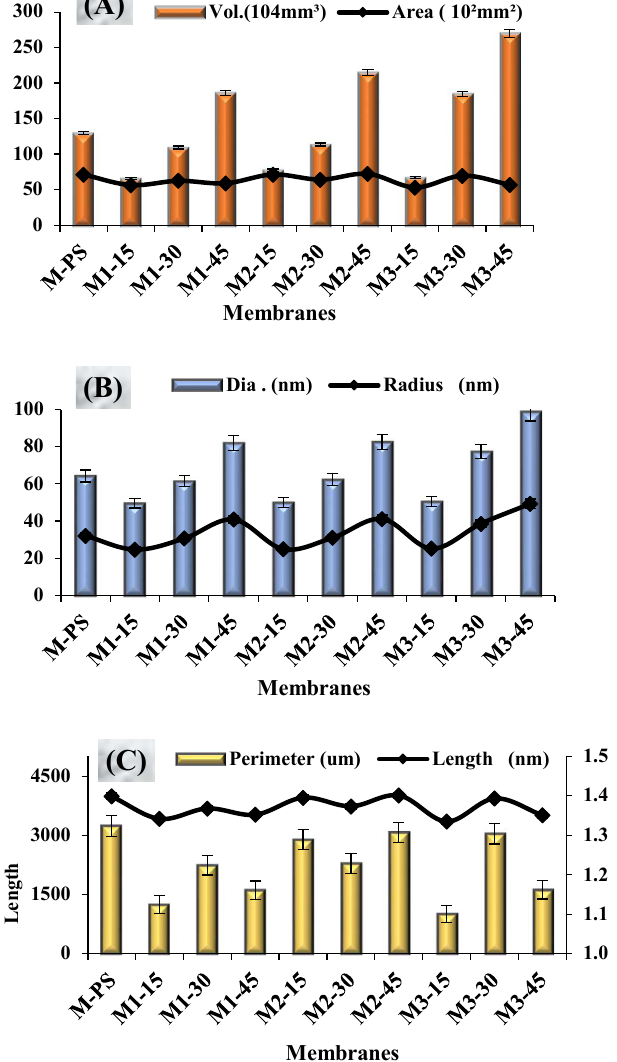
Figure 9. Surface Profiles result of all formulated membranes, obtained via XEI-AFM software of scanned images. ( A )-The volume and area of grains, ( B )-Radius and diameter of surface grain, ( C )-Perimeter and length of grains.